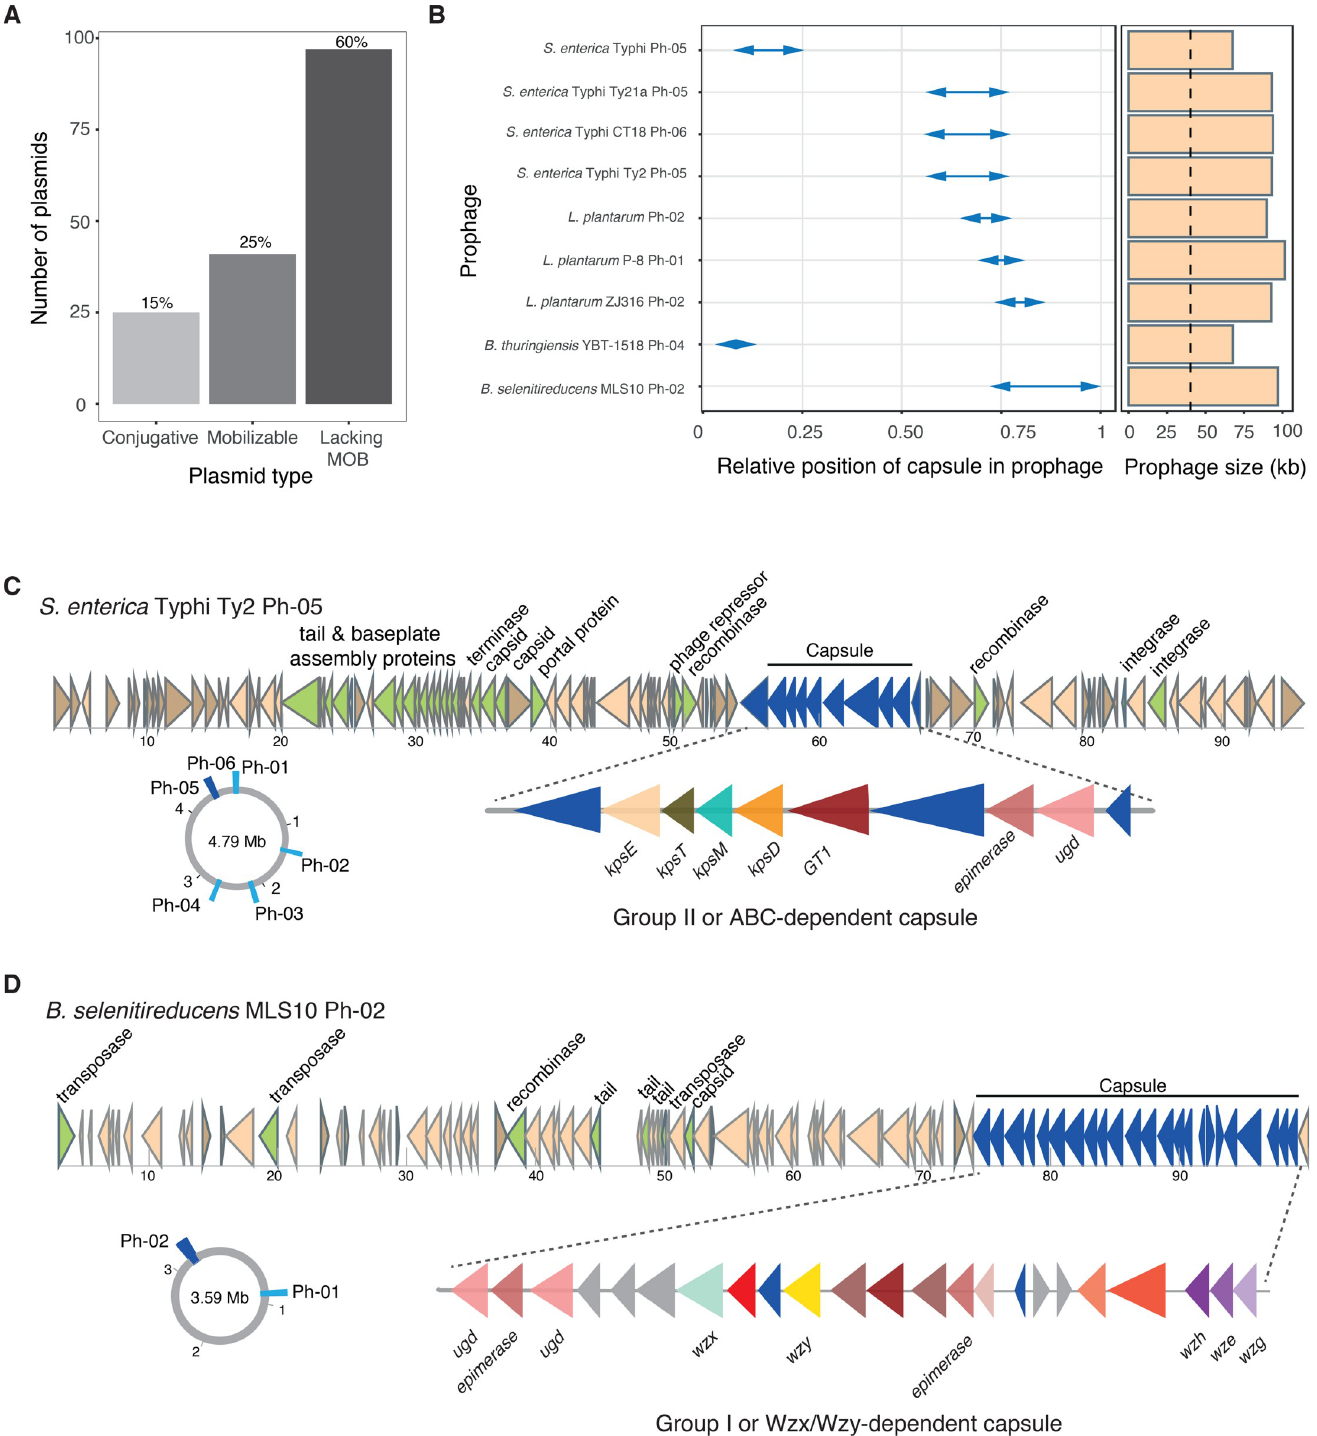
Fig 3. Capsule systems in MGEs. A. Number of plasmids encoding capsule systems in function of the type of plasmid (classed in terms of mobility by conjugation). Plasmids lacking MOB may be mobilized by conjugation if they have a compatible oriT or mobilizable by other unknown means ( e . g ., natural transformation in competent species). B . Details of the nine capsules found in prophages. The arrows indicate the relative position and span of the capsule system in each prophage. Right panel indicates the size of each prophage. Dashed line indicated the average size of prophages in the database (40 kb). C and D. Details of the prophages and capsule systems from S . enterica and B . selenitireducens . Genetic schemes are drawn to scale (kb). In the drawing of the genetic locus of the prophage;